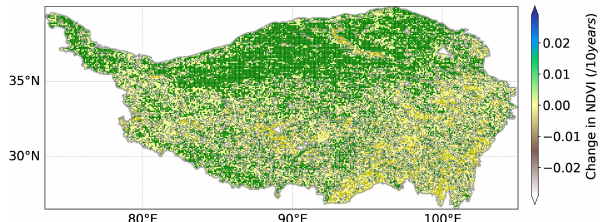
Figure 11. Variations of NDVI over the summer period of May– September from 1982 to 2015 for the Tibetan Plateau. The green/brown (cid:52) / (cid:79) denotes the significant ( p < 0.05) increasing/de- creasing